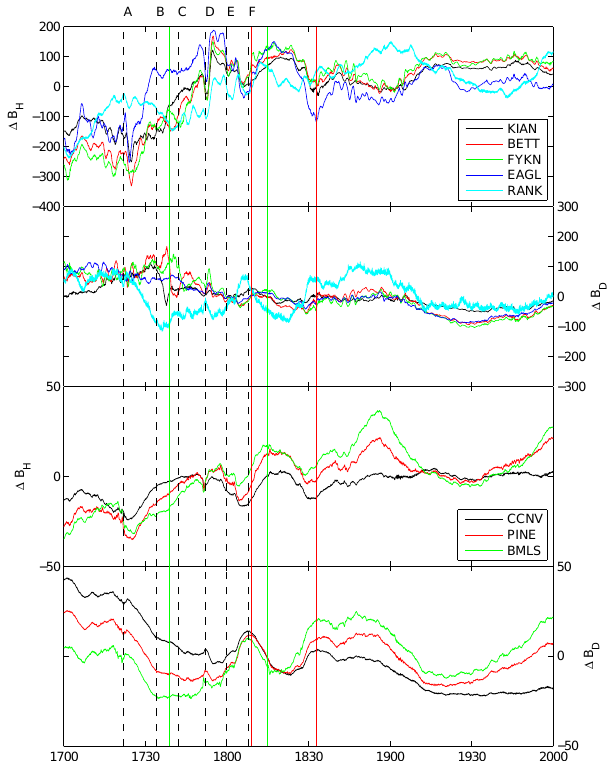
Fig. 8. The 1B H and 1B D components of the high latitude (top) and low latitude (bottom) ground magnetometers from the Canopus chain. For each trace the mean value over the 3h period is sub- tracted. The vertical dashed lines represent the times A through F at which SuperDARN measurements are shown in Fig. 10 and the solid vertical lines show the start and end times of the poleward motion of the aurora as in Fig. 6.